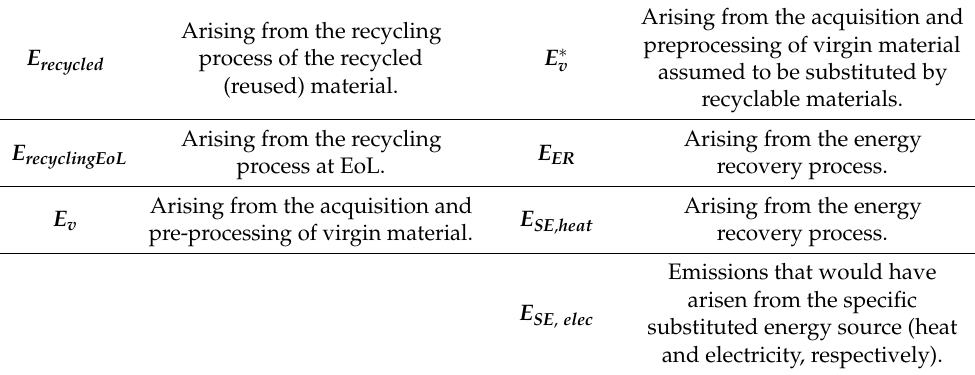
Table A4. Definitions of specific emissions and resources consumed E i